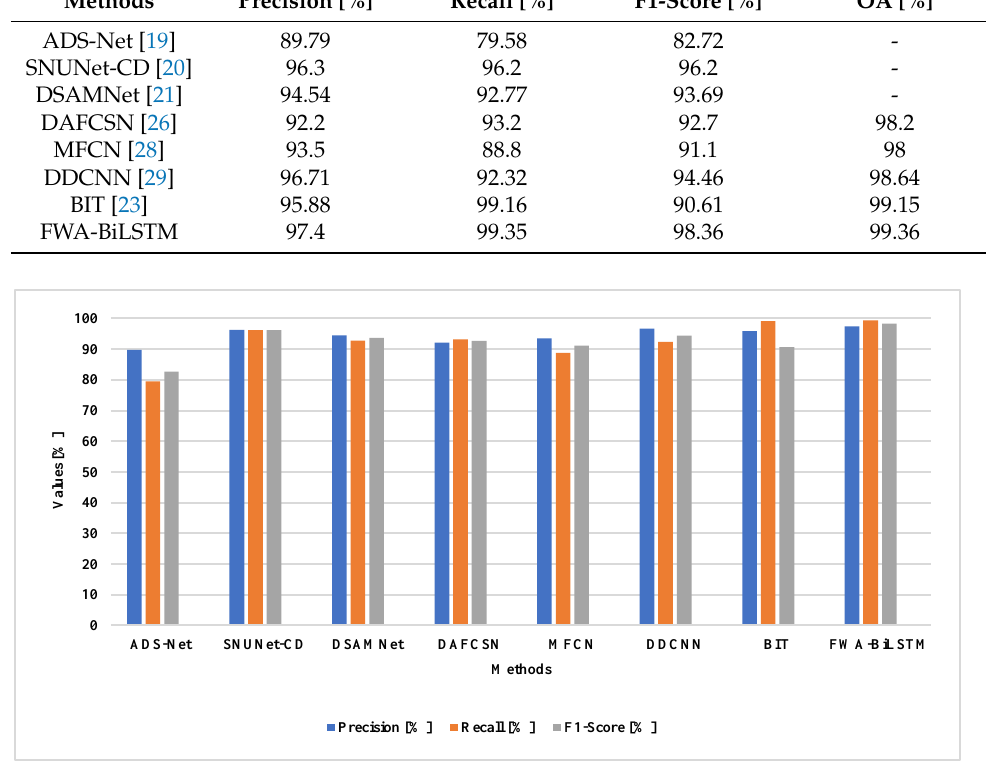
Figure 13. Comparative analysis of the SVD dataset.